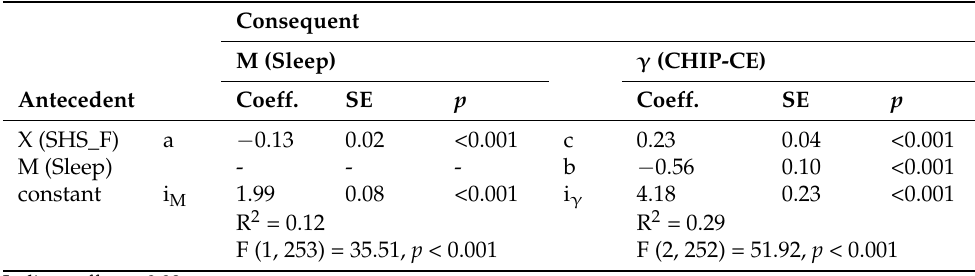
Table 9. Mediation effect of the sleep quality in the link between safe-haven support from the father (SHS_F) and overall well-being.